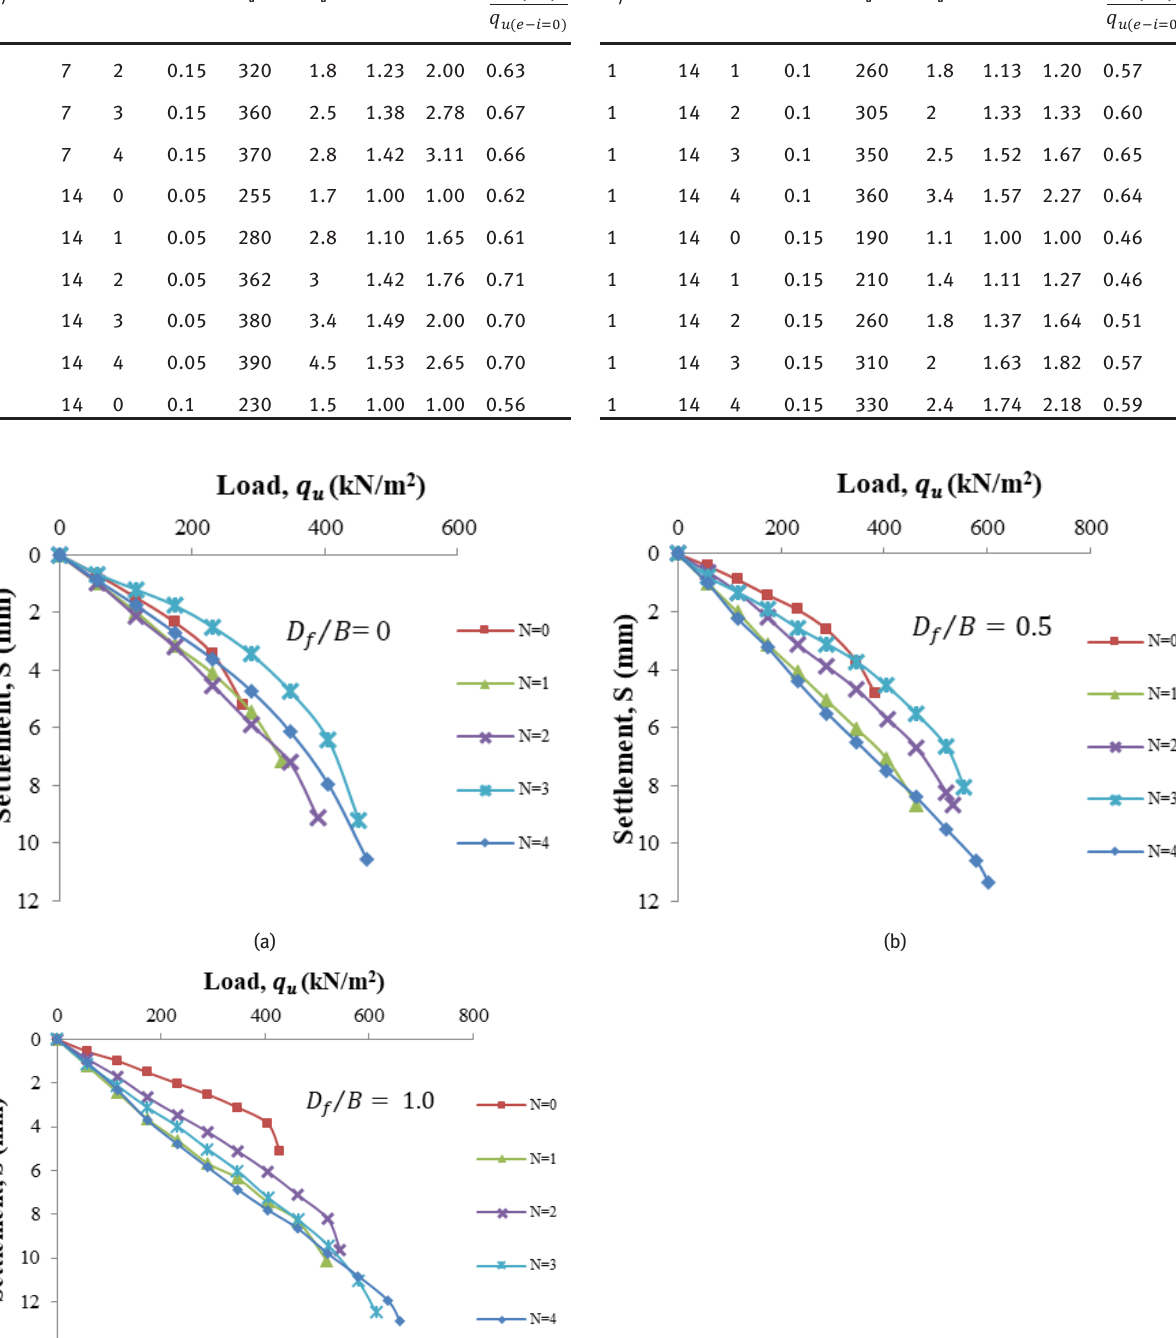
/ B = 0, (b) embedded footing D f